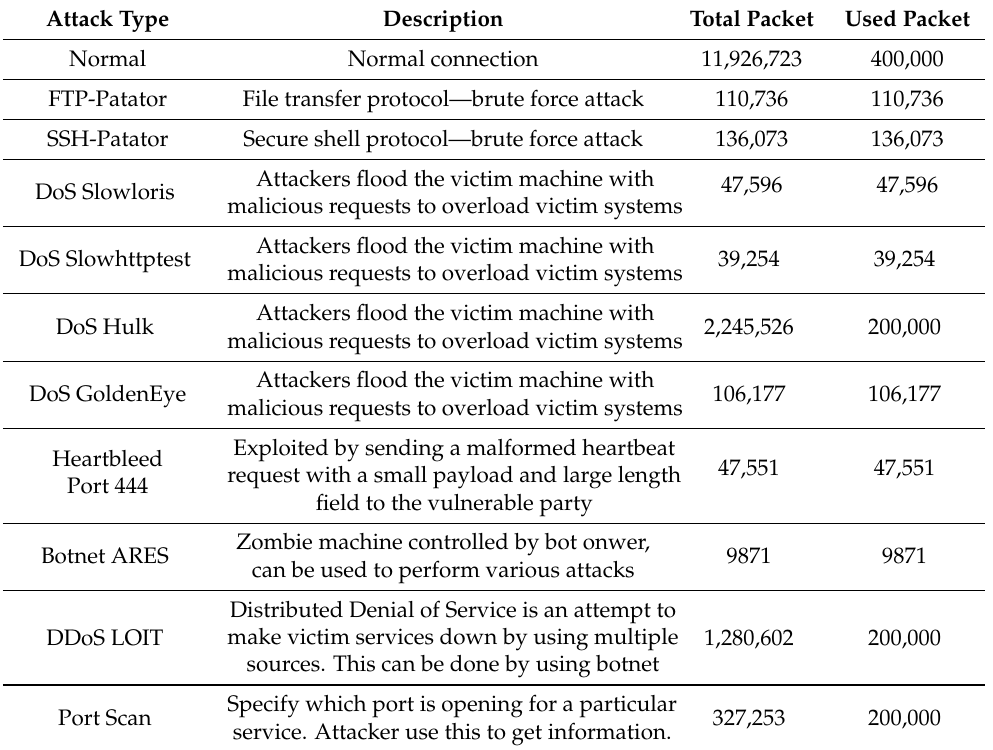
Table 3. Details of the evaluated